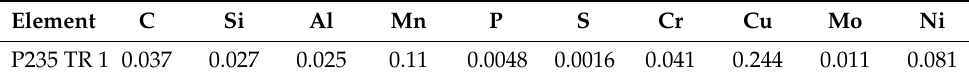
Figure 2. Microstructure of P235 TR 1 investigated by light optical microscope, magnification 500 × . Table 1. Chemical composition of P235 TR 1 in mass percent investigated by optical emission